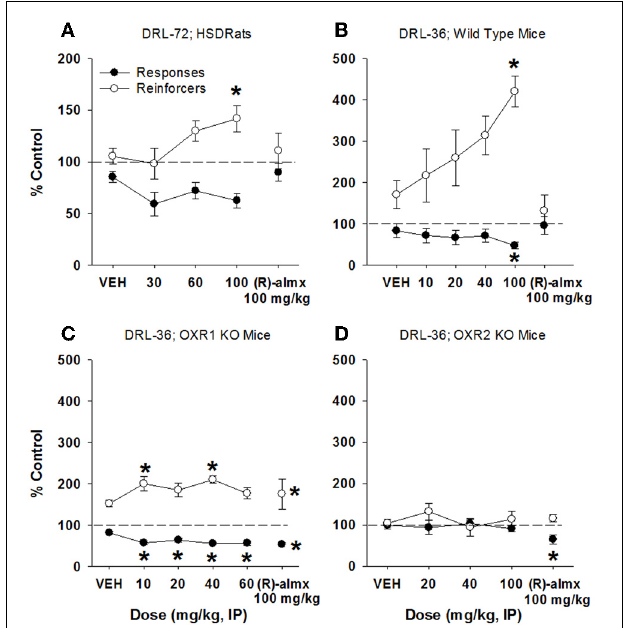
FIGURE 5 | Antidepressant-like effect of almorexant on DRL-72-s responding in rats and DRL-36-s responding in mice. (A) dose-dependent increase in the number of reinforcers obtained by male SD rats in DRL-72-s, with significant effects at 100mg/kg ( p < 0 . 05), as well as a lack of effect of the inactive enantiomer at 100mg/kg ( n = 11); (B) dose-dependent and significant increase in the number of reinforcers obtained ( p < 0 . 05) by C57Bl/6 mice in DRL-36-s at 100mg/kg and a significant decrease ( p < 0 . 05) in total responses emitted at 100mg/kg, as well as lack of effect of the inactive enantiomer at 100mg/kg ( n = 8); (C) significant decrease in responses emitted at all doses tested ( p < 0 . 05) with a concomitant increase in reinforcers received at doses of 10 and 40mg/kg ( p < 0 . 05) in mice lacking OX1 receptors ( n = 8). However, 100mg/kg of the inactive enantiomer also produced significantly fewer responses ( p < 0 . 05) with a concomitant increase in reinforcers received ( p < 0 . 05) in mice lacking OX1 receptors; (D) almorexant failed to produce antidepressant-like effects in mice lacking OX2 receptors, up to 100mg/kg ( n = 8). The inactive enantiomer (100mg/kg) significantly reduced total responses emitted in mice lacking OX2 receptors ( p < 0 . 05), without significantly affecting reinforcers earned ( n = 8). ∗ p < 0 . 05 vs. respective vehicle, Dunnett’s post-hoc analyses.